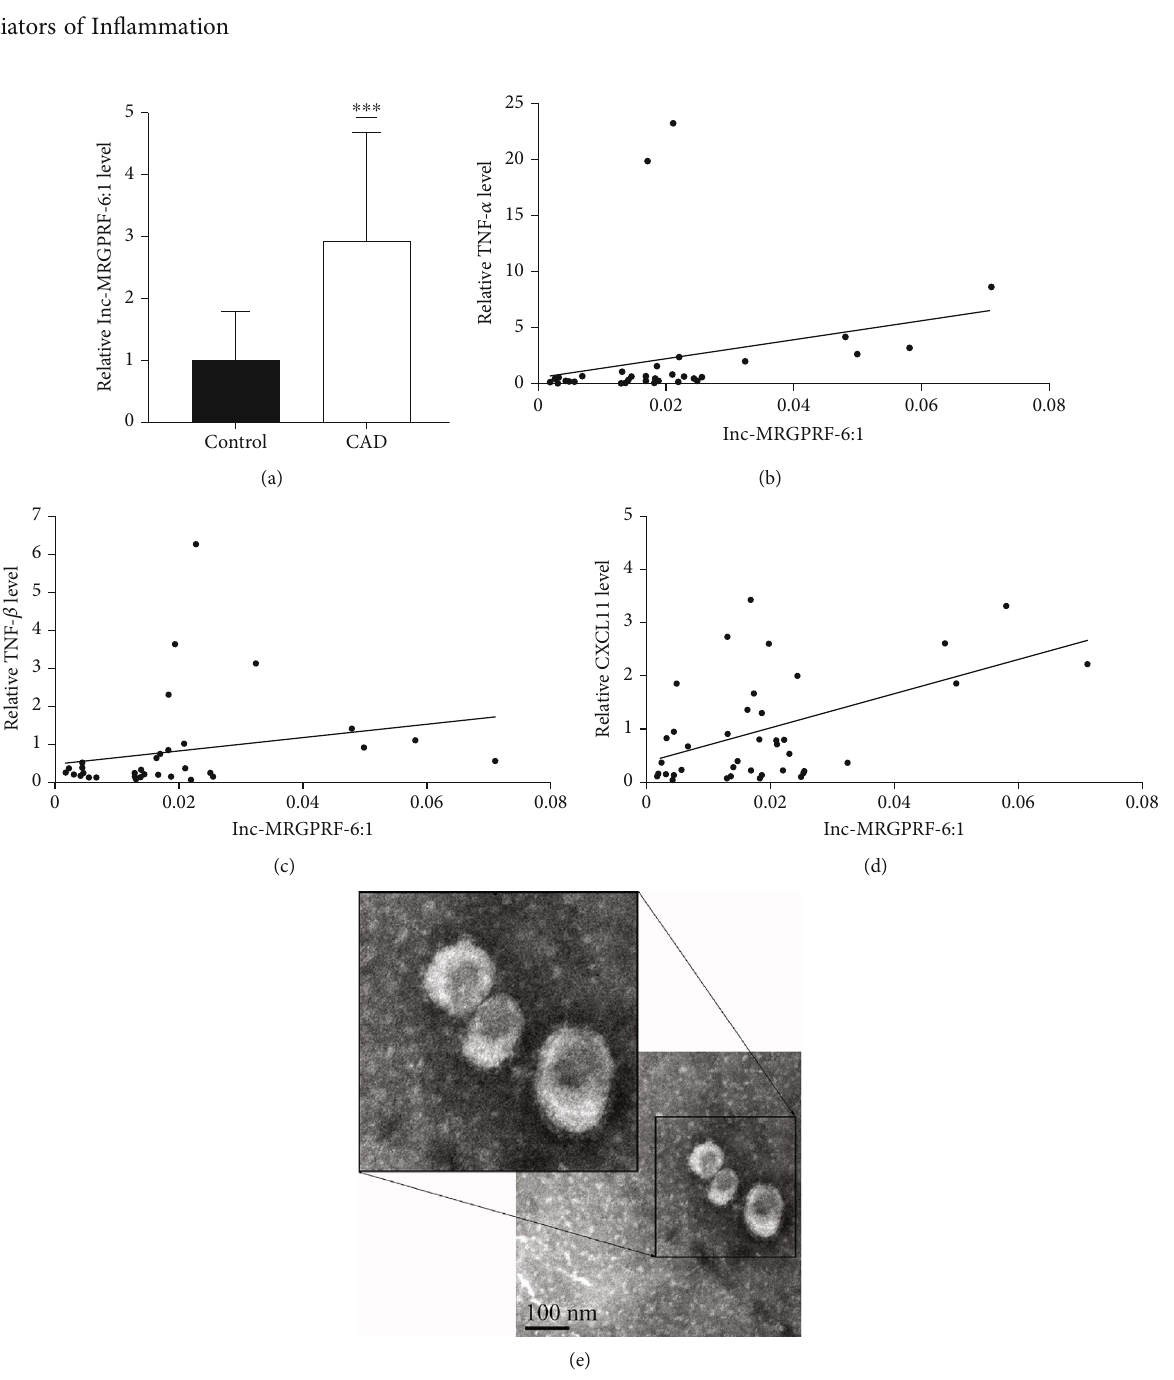
Figure 1: lnc-MRGPRF-6:1 signi fi cantly increased in plasma exosomes of CAD patients and was associated with in fl ammatory factors in plasma. (a) The mRNA level of lnc-MRGPRF-6:1 in the plasma exosomes was detected by RT-qPCR. (b – d) Scatter plot of Spearman correlation analysis between lnc-MRGPRF-6:1 and TNF- α (Spearman r = 0 : 544 , P = 0 : 001 ), TNF- β (Spearman r = 0 : 469 , P = 0 : 005 ), and CXCL11 (Spearman r = 0 : 376 , P = 0 : 018 ) expression levels in plasma. (e) Electron microscopy image of exosome enrichment isolated from plasma (scale bar, 100 nm). CAD vs. control, ∗∗∗ P < 0 : 001 . CAD: coronary atherosclerotic Table 2: Relative expressions of TNF- α , TNF- β , and CXCL11 at the transcription level between CAD patients and controls (U6 as an internal reference). The data were expressed as median (1st/3rd quartiles).